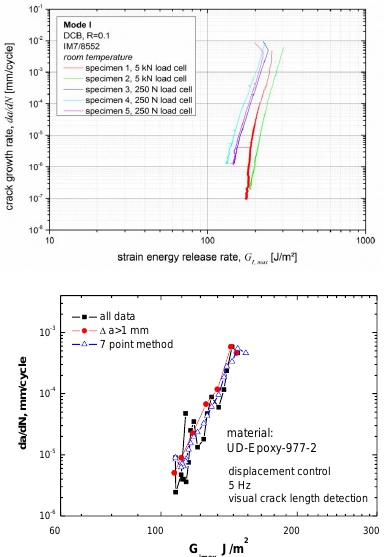
Figure 5. Graphs illustrating scatter in Mode I fatigue fracture testing: (top) for the CFRP laminate (IM7/8552), due to differences in test set-up, except for the capacity range of the load cell (5 kN versus 250 N), the set-up is identical; (bottom) for the CFRP laminate (IM7/977-2), from data analysis, the full data set from visual delamination length observation (black squares) is reduced by showing only data with at least a 1 mm delamination length increase (red circles), and by fitting using the seven-point method (blue triangles) according to [72]. Table 1. Average errors in blind predictions of residual strength after fatigue loading of the seven models benchmarked in Reference [77]. Load Condition